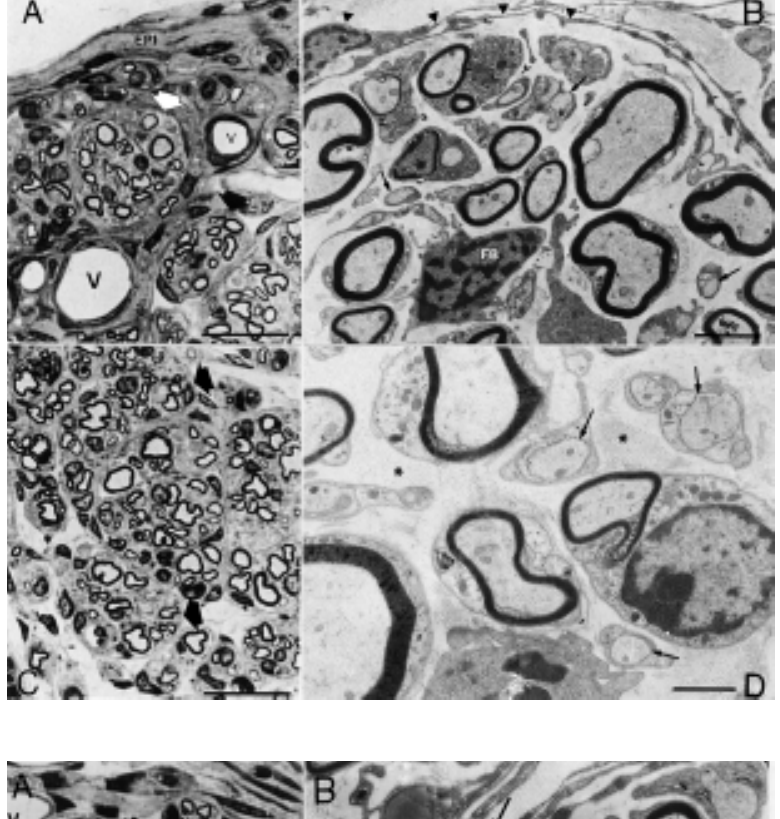
Figure 4 - A , Transverse section of a regenerated nerve 4 weeks after BALB/cJ isograft transplantation. The regenerated fibers are distributed into fascicles bor- dered by circumferential projections of perineural cells (arrows). Blood vessels are also observed (V). Bar